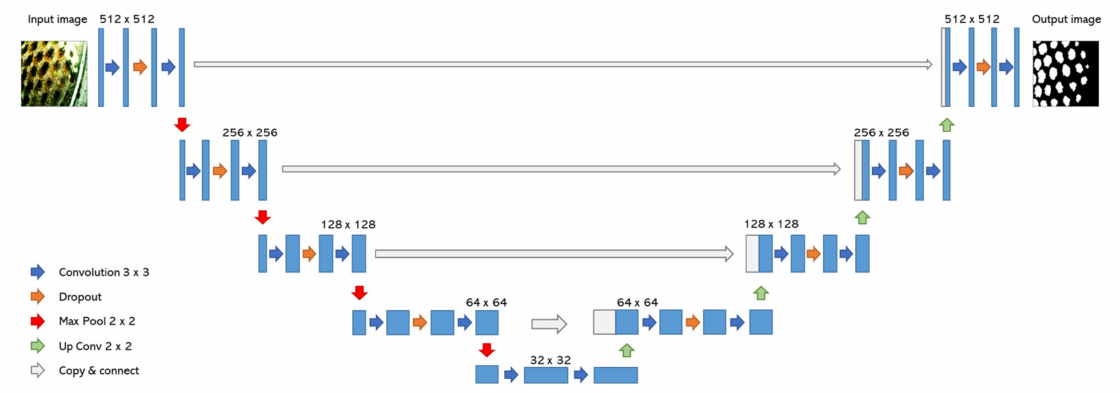
Figure 1. Architecture of the modified U-net network implemented in the